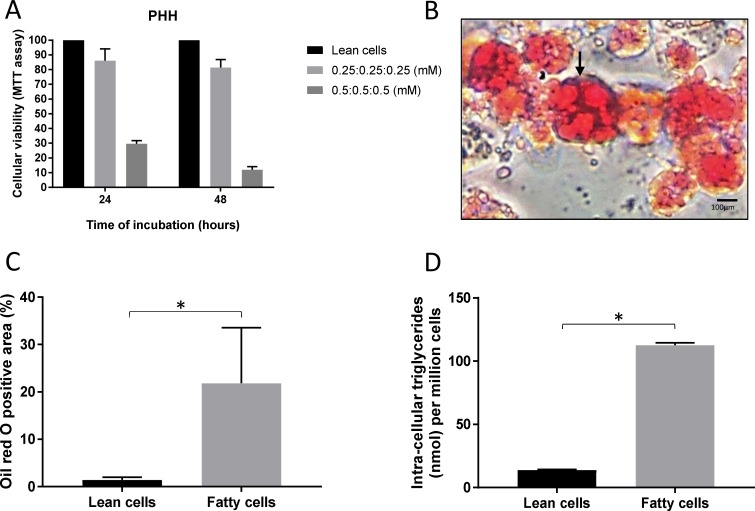
Results of fat loading of primary human hepatocytes.Panel A: The supplementation of the media with the combination of fatty acids resulted in a cell viability rate of 81% after 48 hours of incubation. Panel B: Oil red O staining image of PHH at the end of the fat loading period. There is predominance of large lipid droplets displacing the nucleus of the cells to the periphery (black arrow). Panel C: At the end of 48 hours of fatting load there was a significant increase of 14-fold of the positive area of oil red O. Panel D: Intracellular triglycerides increased 8-fold within 48 hours of incubation with fatty acids. Data report the median of three separate experiments performed in quadruplicate and errors bars the interquartile range. Comparisons performed using two-tailed t-test. * = p<0.05.